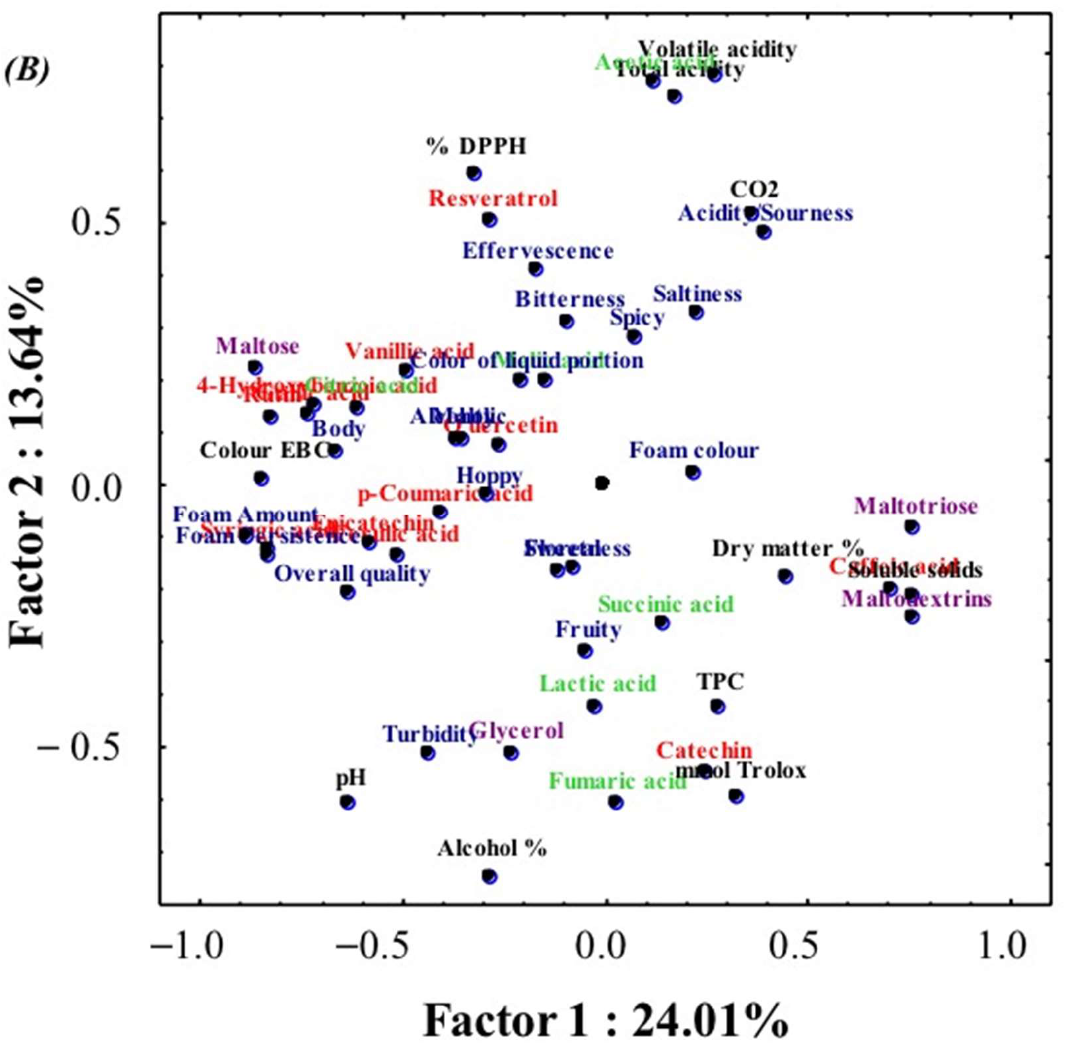
Figure 1. Principal Component Analysis (PCA): projections of ( A ) beers and ( B ) their analytical profiles on the factorial plane. Phenolic compounds are reported in red font; organic acids are in green; sugars and glycerol are in purple; sensory attributes are reported in blue; the other variables are in black.